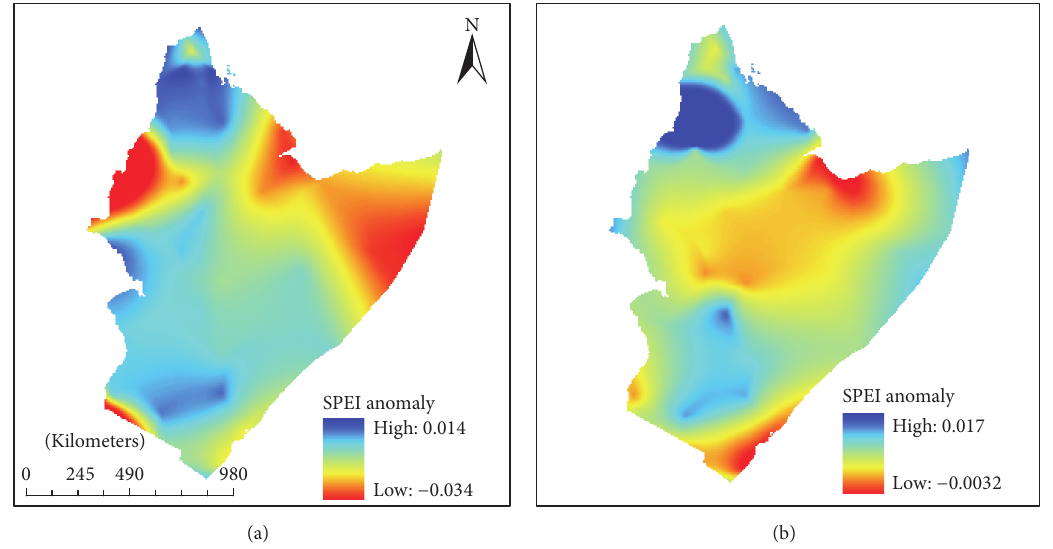
Figure 4: The composite SPEI anomaly of wettest (a) and driest (b) years in the HOA from 1930 to 2014.